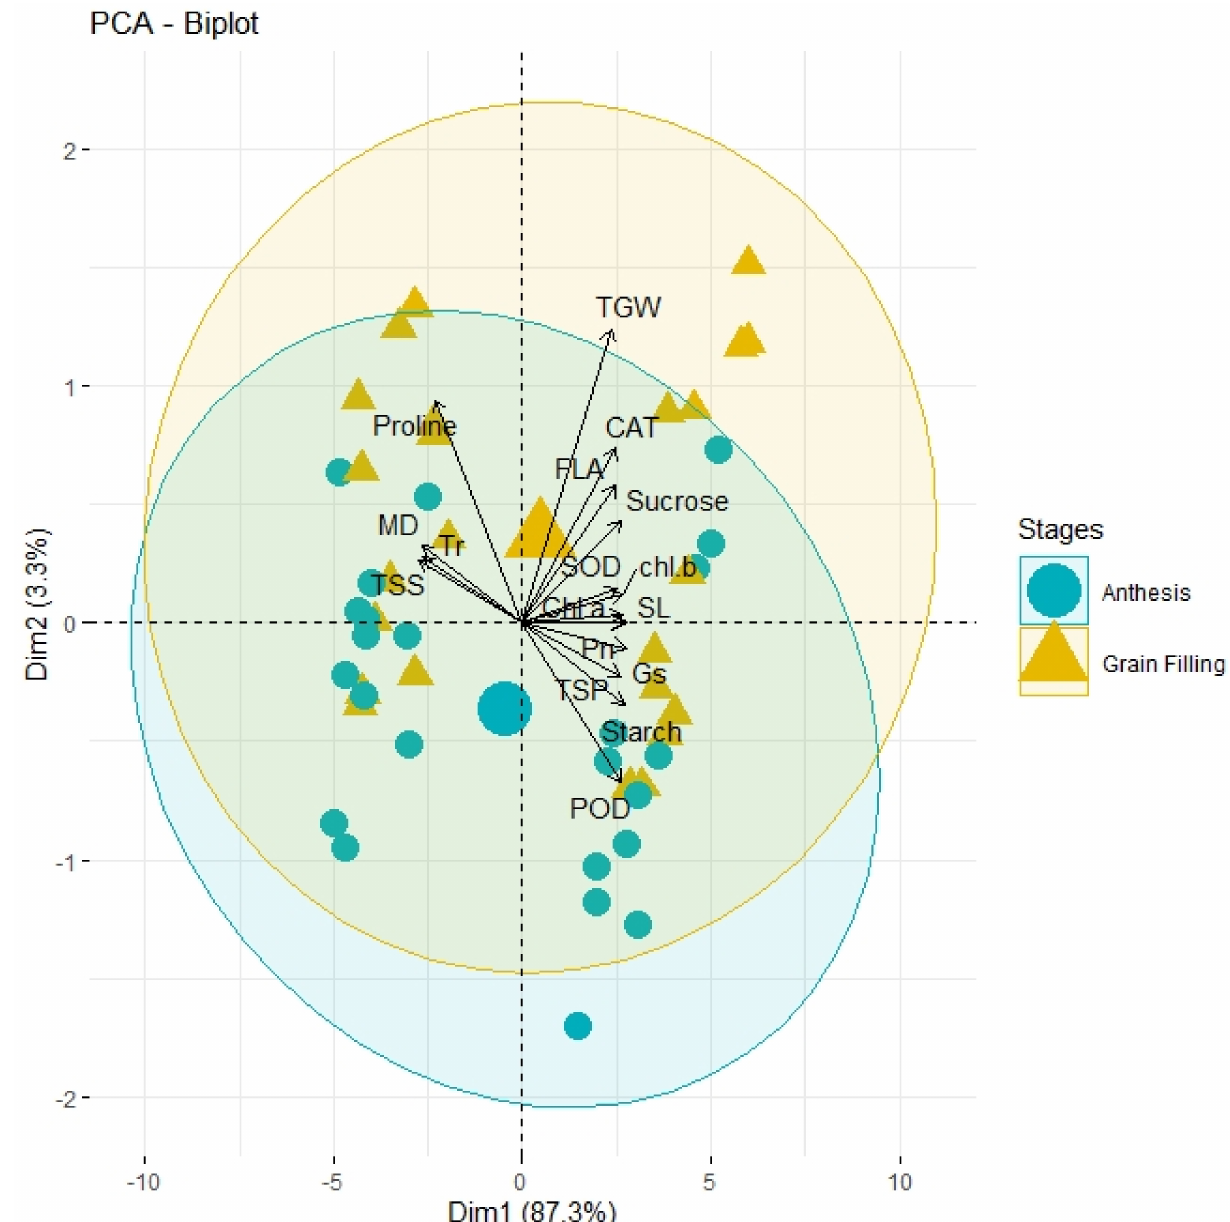
Figure 9. PCA graphic scattered plot of osmolytes, physiological parameters, antioxidant enzymes and agronomic trait clustered according to their similarity and dissimilarity at anthesis and grain-filling stages of wheat genotypes. The vectors derived from biplot origin represent positive and negative association among traits: TSS, total soluble sugar; TSP, total soluble proteins; Gs, stomatal conductance; Tr, transpiration rate; MD, membrane damage; Pn, photosynthesis rate; SOD, superoxide dismutase; CAT, catalase; POD, peroxidase; FLA, flag leaf area; SL, spike length; TGW, thousand grain